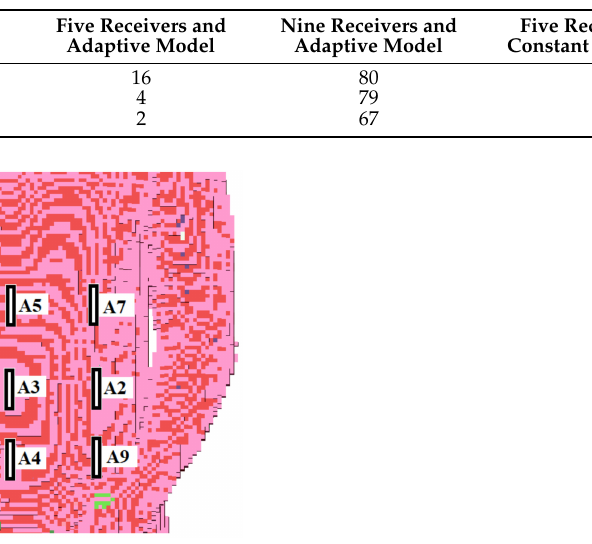
Table 1. The impact of the number of receivers on localization accuracy.